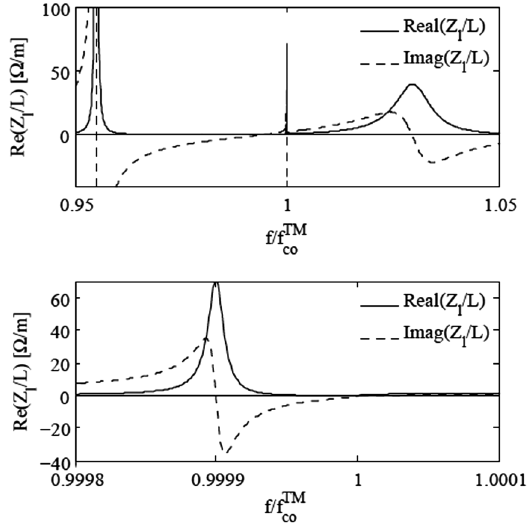
FIG. 14. Example of longitudinal impedance calculation for an alumina insert: L ¼ 8 mm, t ¼ 30 cm, b ¼ 5 cm. The trapped ¼ 2 . 2946 GHz. The insert material is an mode is located at f trap ¼ 9 . 4 , tan δ ¼ 4 × 10 − 4 ). alumina 96% foil ( ε 0 r